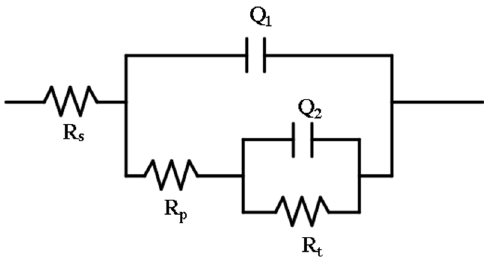
Figure 12. Test steel electrode surface corrosion process EIS equivalent simulation circuit diagram.